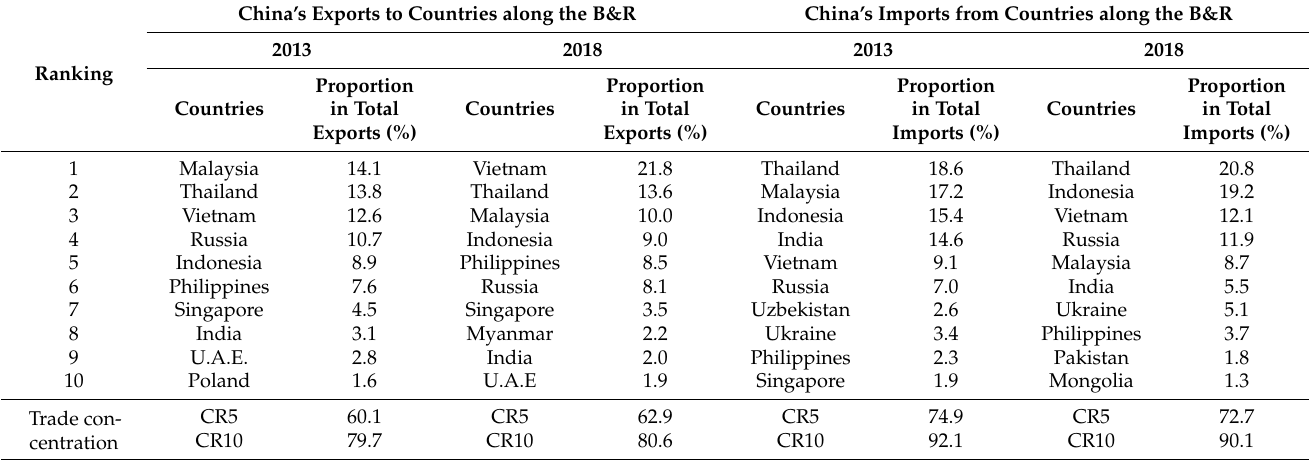
Table 3. The top 10 countries along the B&R in agricultural trade and their proportion in total agricultural trade amount with China in 2013 and